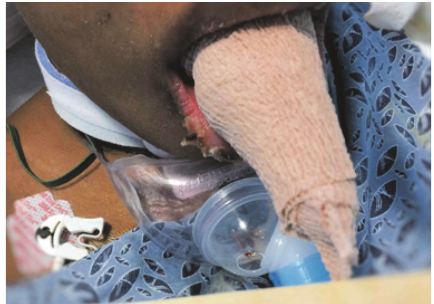
Figure 2: Lingual wrap in place. Self-adherent wrap